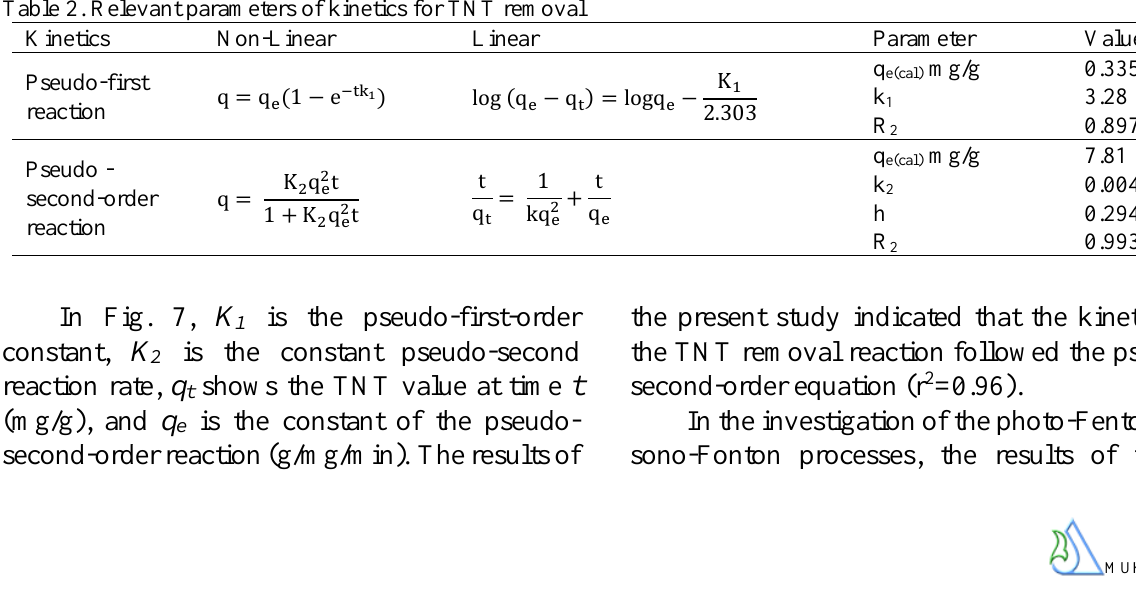
Table 2. Relevant parameters of kinetics for TNT removal Kinetics Pseudo-first